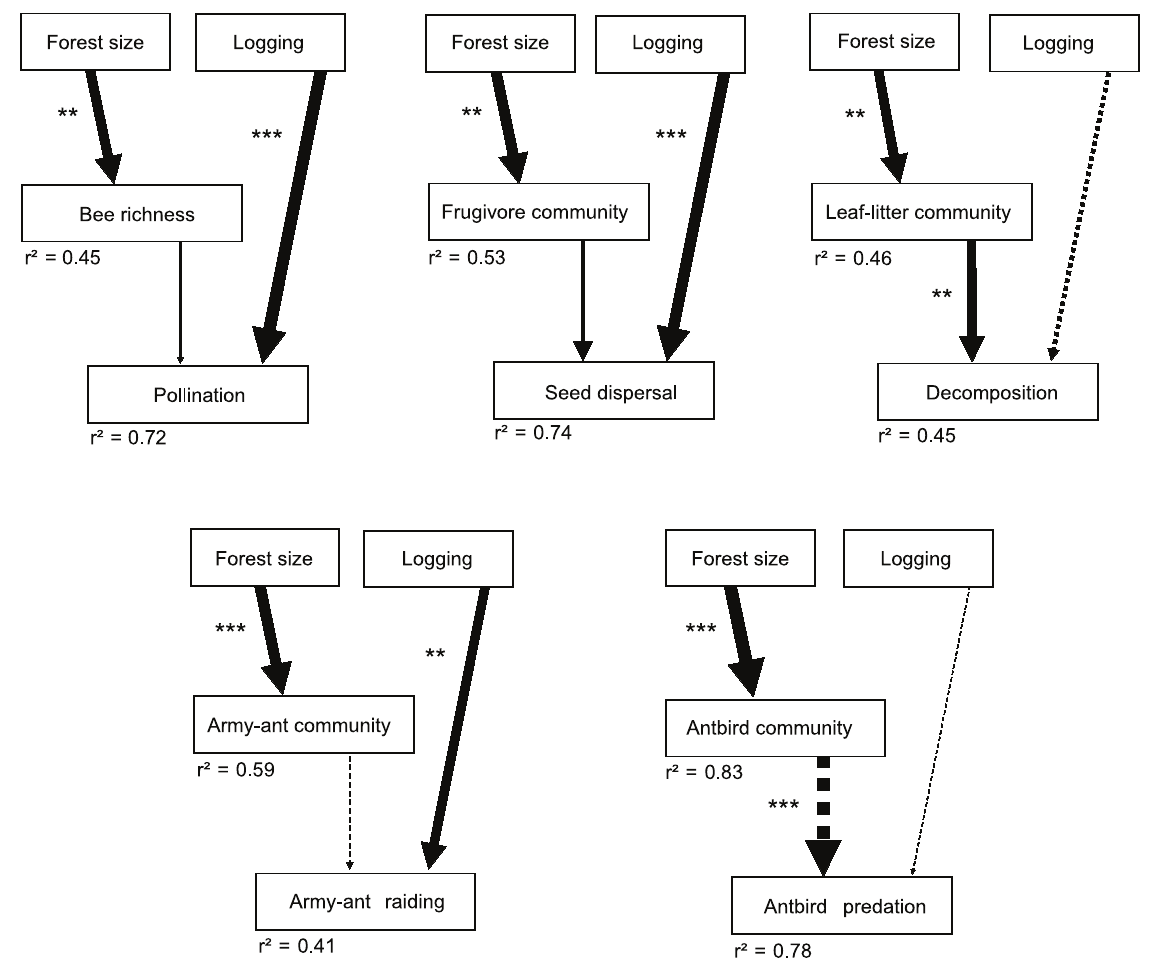
Figure 3. Path models of the indirect effects of forest size and the direct effects of selective logging on five ecosystem processes. Human disturbance increases from low to high values (forest size was multiplied by 2 1). Biodiversity effects were tested as follows: observed species richness (bees) and site scores of the first NMDS axis (frugivores, leaf litter fauna, army ants, antbirds); the relationships between human disturbance and community composition are by default positive. Arrow width is proportional to path coefficients; continuous arrows show positive, and dotted arrows negative effects. Asterisks indicate significance of path coefficients from maximum-likelihood (ML) estimates. The proportion of explained variance r 2 is given for each response variable. Table S2 provides the number of study sites, exact path coefficients and P -values from ML and bootstrap estimates. *, P , 0.05; **, P , 0.01; ***, P , 0.001.